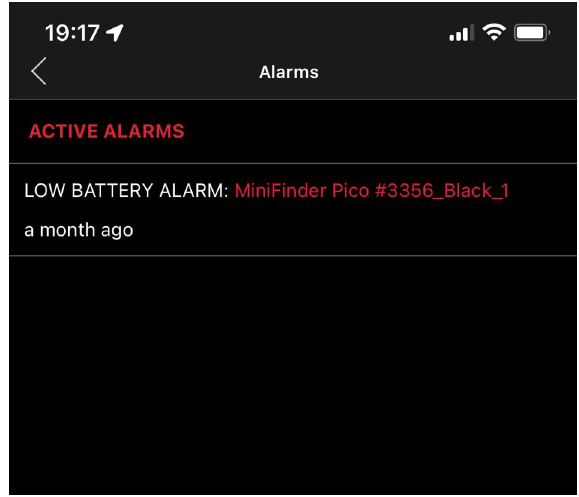
Figure 7. Low battery alarm.